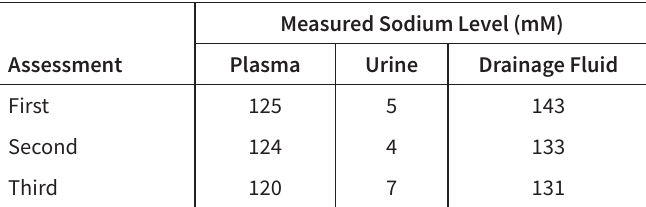
Table 1. Values of Concurrent Measurement of Sodium in Plasma, Urine, and Drainage